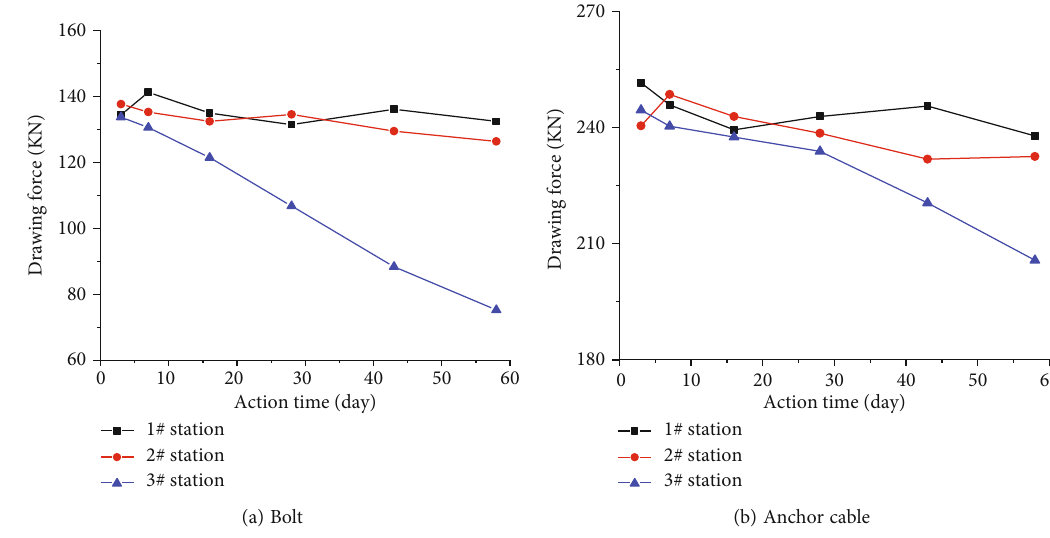
Figure 7: The test results of drawing force with anchor